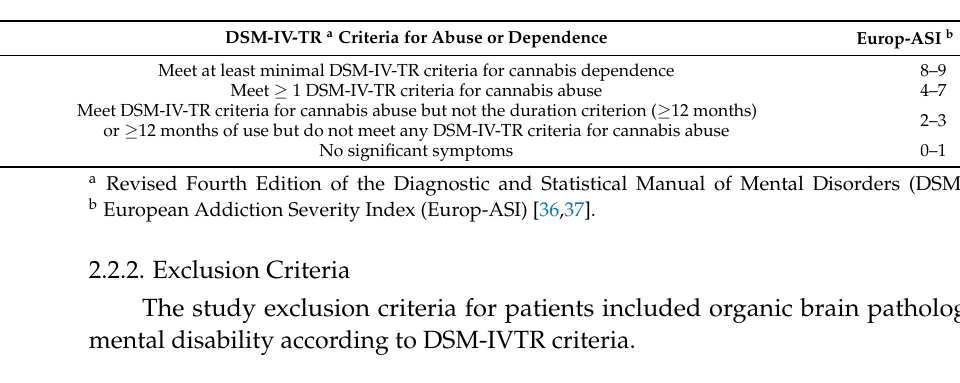
Table 1. Classification of cannabis use for selection of